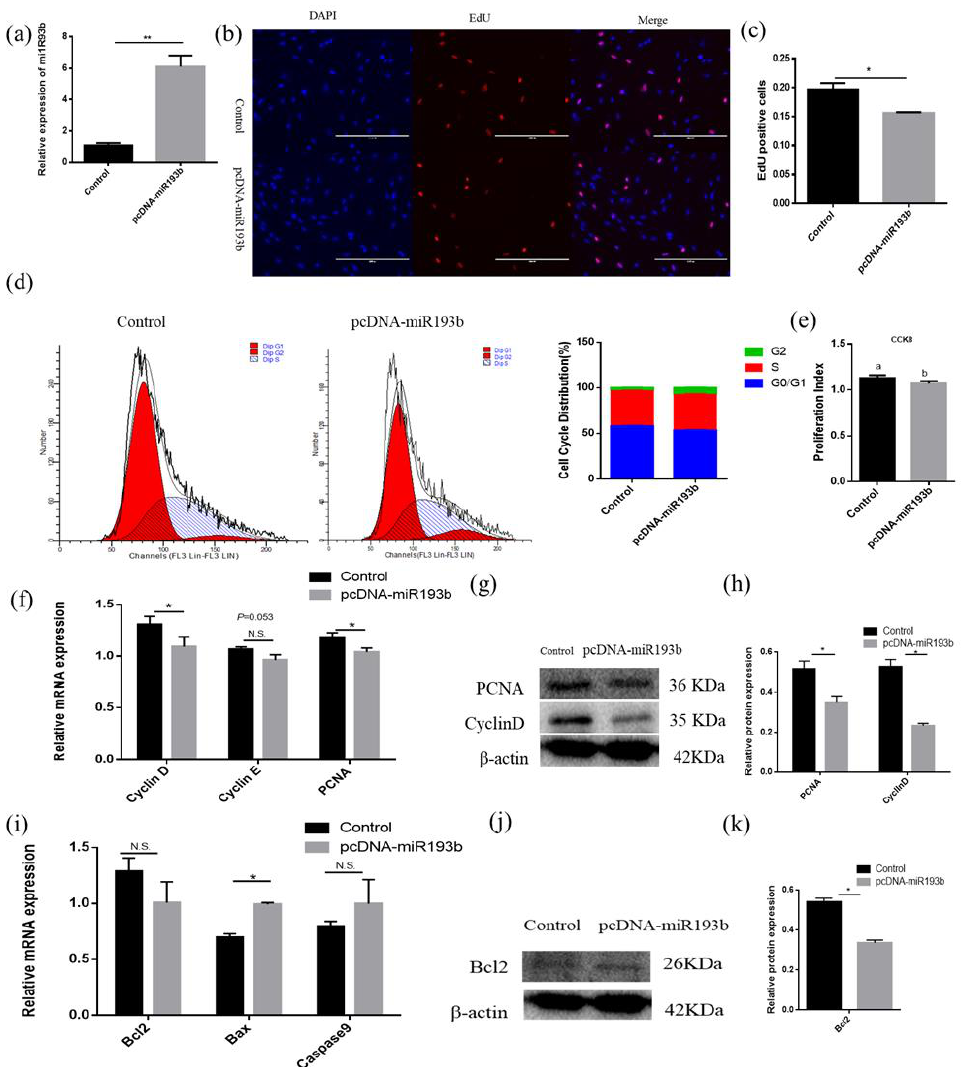
Figure 3. Bta-miR-193b inhibits adipose cells proliferation and promotes adipose cells apoptosis. ( a ) Overexpression efficiency detection. ( b ) EdU detected cell proliferation index; the scale bar stand 200 μm. DAPI (blue), EdU (red). ( c ) Analysis results of EdU positive cells. ( c ) Cell cycle distribution was detected by PI flow cytometry after a gain of bta-miR-193b. ( d ) Cell proliferation status was detected at 450 nm with CCK -8 reagent, after gain of bta-miR-193b. ( e ) Cell cycle-related genes ( cyclinD , cyclinE and PCNA ) mRNA expression level was detected by RT-qPCR after a gain of bta-miR-193b. ( f – k ) Expression of cell cycle-related and apoptosis-related genes were detected by RT-qPCR and Western blot. Values are mean ± SD for three biological replicates, * p < 0.05, ** p < 0.01.